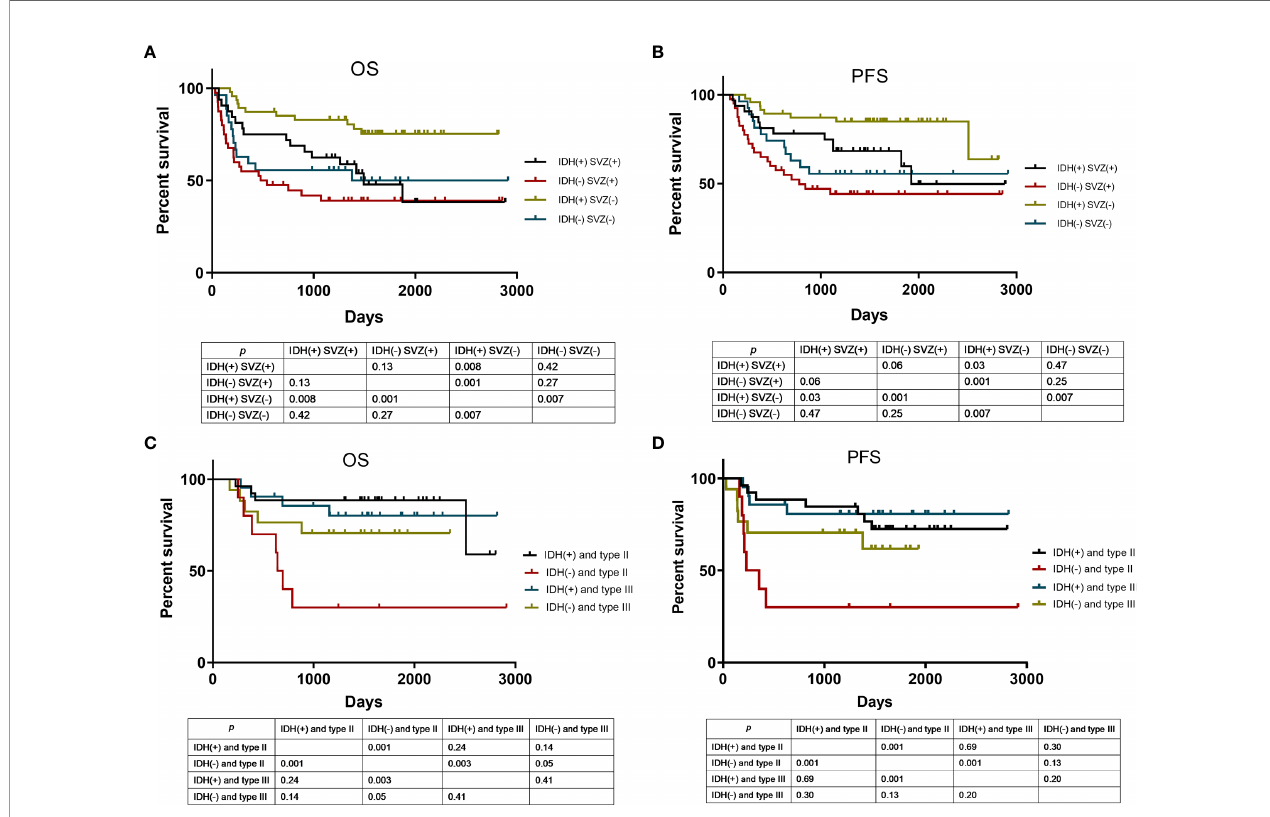
FIGURE 4 | Kaplan-Meier curve analysis according to various risk categories. OS (A) and PFS (B) analysis using Kaplan-Meier curves in patients strati fi ed by SVZ involvement and IDH1 mutation status. Of the patients without SVZ involvement, they were strati fi ed by tumor-SVZ distance and IDH1 mutation status for OS (C) and PFS (D) analysis using Kaplan-Meier curves. SVZ (+) means SVZ involvement, SVZ ( − ) means SVZ non-involvement. IDH (+) means IDH1 mutation, IDH ( − ) means IDH1 wild type. Type II means tumor-SVZ distance from 0 to 10 mm; type III means tumor-SVZ distance >10